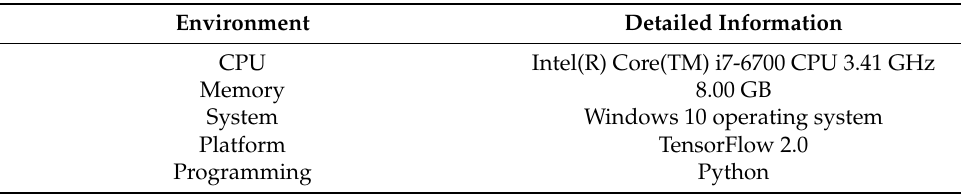
Table 7. Experimental environment in this study.